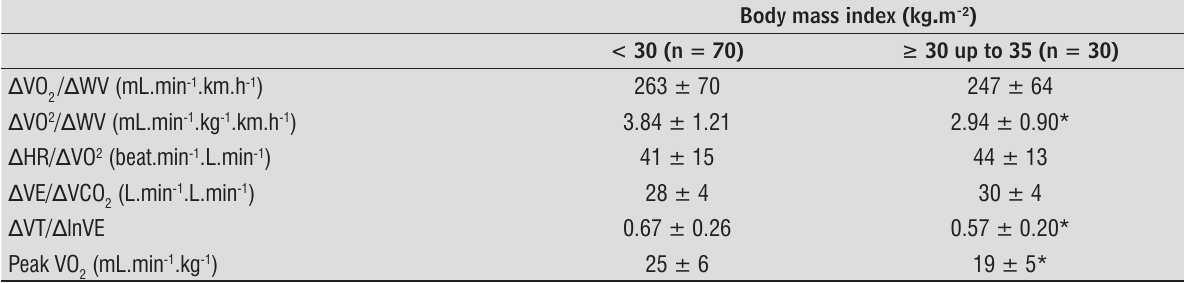
Table 4 - Dynamic physiological responses and peak oxygen uptake to the incremental shuttle walk test in obese and non- obese participants